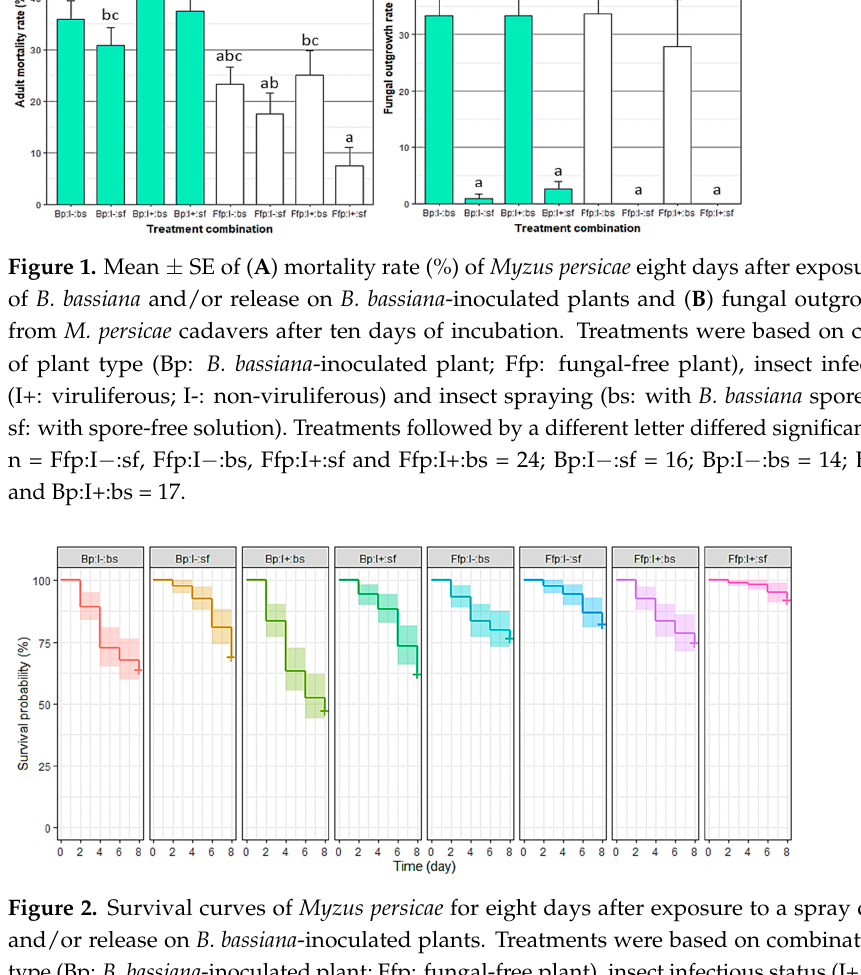
Figure 1. Mean ± SE of ( A ) mortality rate (%) of Myzus persicae eight days after exposure to a spray of B. bassiana and/or release on B. bassiana -inoculated plants and ( B ) fungal outgrowth rate (%) from M. persicae cadavers after ten days of incubation. Treatments were based on combinations of plant type (Bp: B. bassiana -inoculated plant; Ffp: fungal-free plant), insect infectious status (I+: